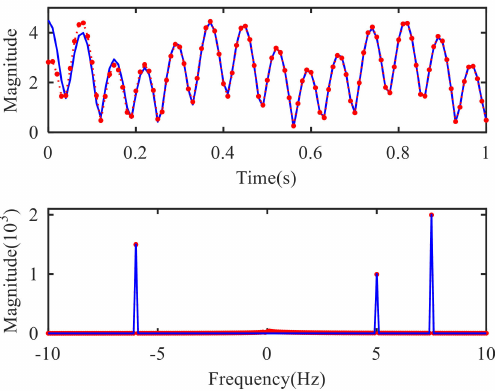
Figure 2. Original signal (blue solid line) and reconstruction signal by CVMD (red dashed